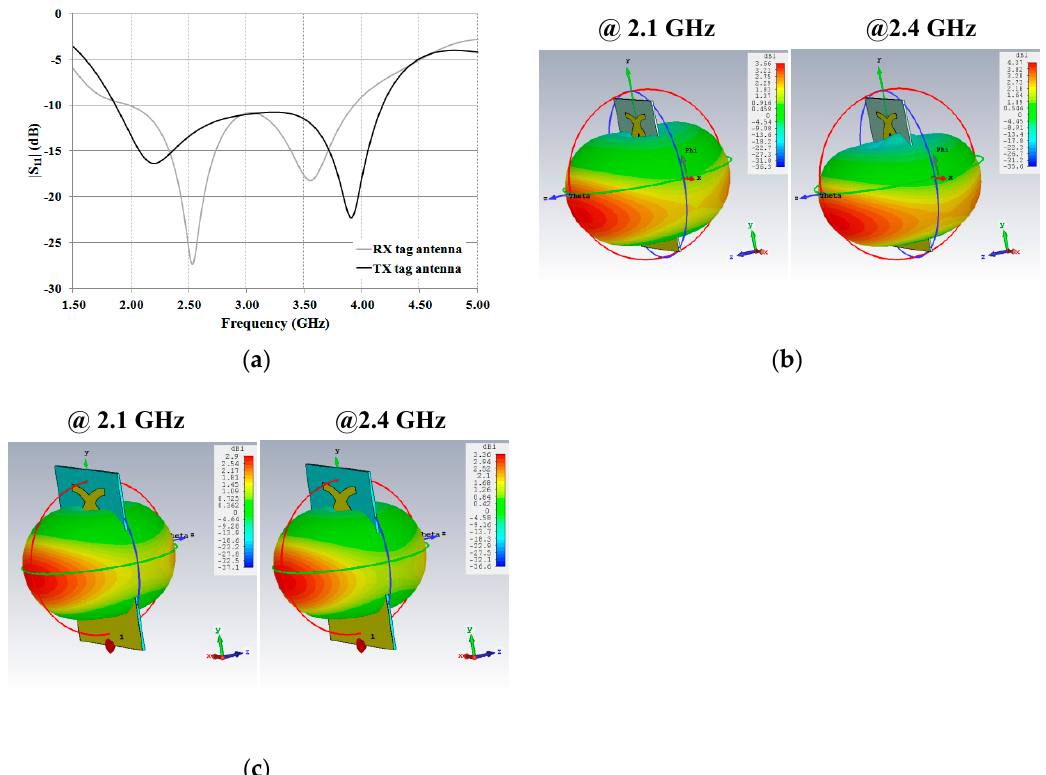
Figure 6. Numerical results achieved for the RX and the TX tag antennas: ( a ) comparison between the |S 11 | of the two monopoles; ( b ) 3D radiation patterns of the RX tag antenna calculated at 2.1 GHz and 2.4 GHz (b); ( c ) 3D radiation patterns of the TX antenna calculated at 2.1 GHz and 2.4 GHz.